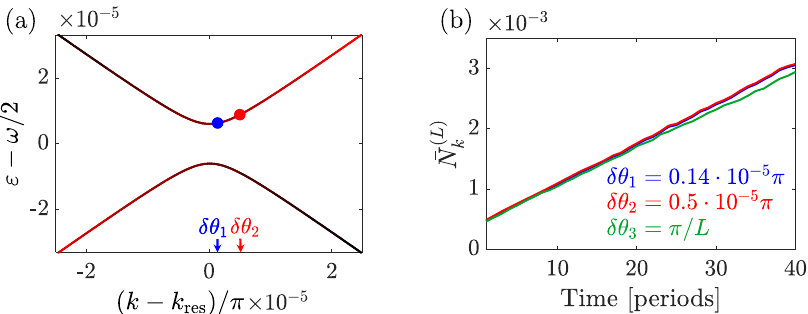
FIG. 7. (a) Single-particle Floquet spectrum in the vicinity of an avoided crossing between the two counterpropagating bands. In this 1 . 2856033 π . We use twisted calculation, J 0 ¼ 1 . 5 , J 1 ¼ 1 , V 1 ¼ 3 , U ¼ 3 , and ω ¼ 0 . 3 . The single-particle resonance is at k res ¼ boundary conditions to tune one of the allowed k points in our L ¼ 16 system near the resonance; the k points nearest to k , res corresponding to twist angles δθ 1 and δθ 2 , are shown by blue and red dots, respectively. (b) Total occupation number of the left-moving Floquet band, excluding the k point nearest to k , as a function of time, for three different twist angles, δθ 1 . Two of the twist angles, ; 2 ; 3 res δθ δθ 1 and 2 , are such that there is a k point close to k res (blue and red curves, respectively), while for the third angle, δθ 8 particles in an L ¼ 16 unit cells system. The 3 , none of the k points are near k res (green curve). This is a simulation of N ¼ interaction strength is U ¼ 3